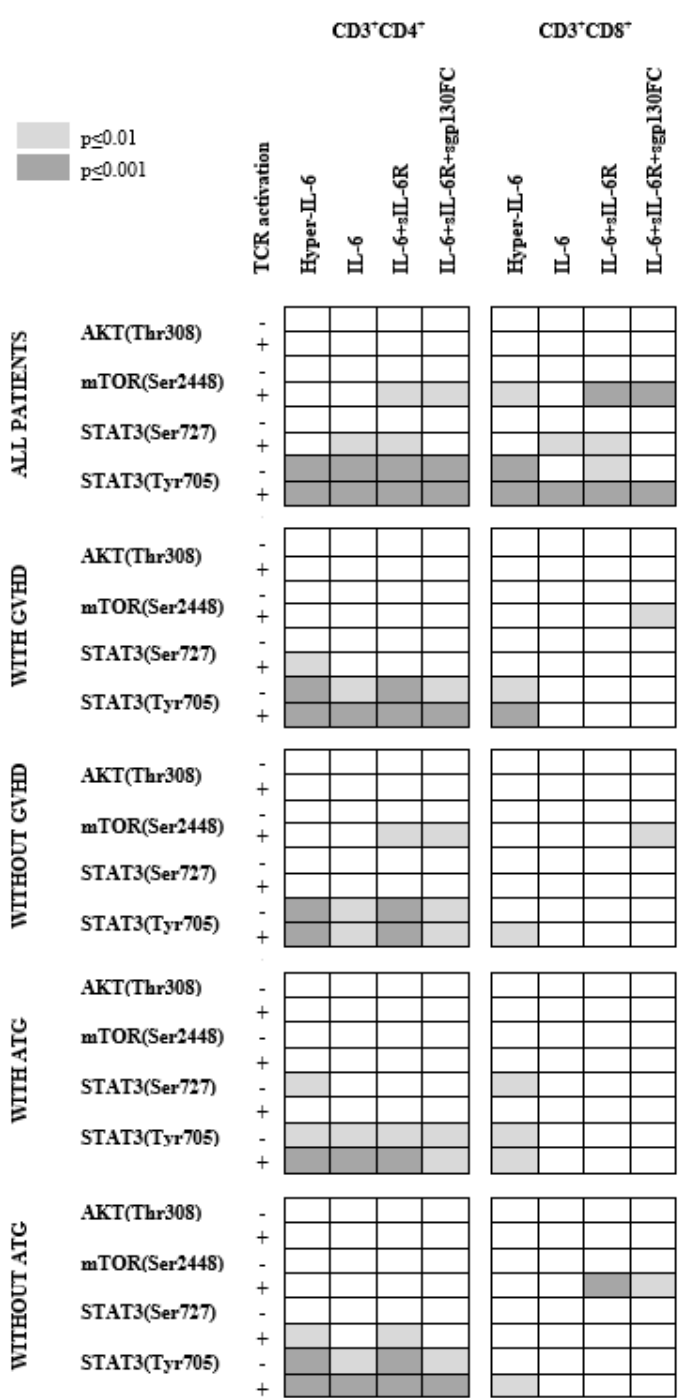
Figure 5. The IL-6 responsiveness of CD3 + CD4 + and CD3 + CD8 + T cells derived from allotransplant recipients at day +90 post-transplant. We investigated the effects of four different forms of IL-6 stimulation on the T cell subsets: IL-6 alone (classical IL-6 signaling), hyper-IL-6 (trans-signaling), IL-6 plus sIL-6R (classical and trans-signaling) and IL-6+sIL-6R+sgp130FC (classical Il-6 signaling; trans-signaling blocked by sgp130FC). We investigated the effects of these signals on AKT (Thr308), mTOR (Ser2448), STAT3 (Ser727) and STAT3 (Tyr705) phosphorylation in resting cells and in TCR- activated cells (anti-CD3 + anti-CD28). We analyzed the overall results for the 31 patients. All statistical analyses were carried out using the Wilcoxon signed-rank test. The figure summarizes our overall results (see Tables 3 and 4), but due to the overall number of comparisons, we only present differences with a p -value <